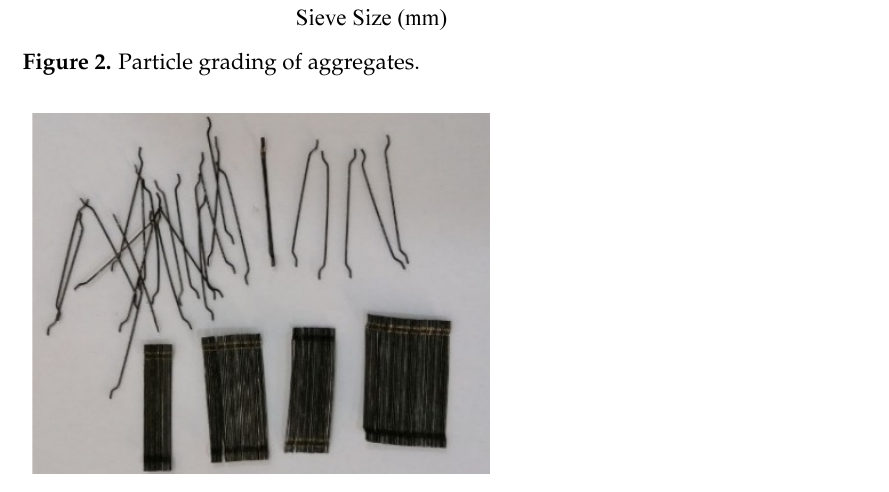
Figure 3. Used hooked-end steel fibers. Table 2. Concrete mixtures (kg/m 3